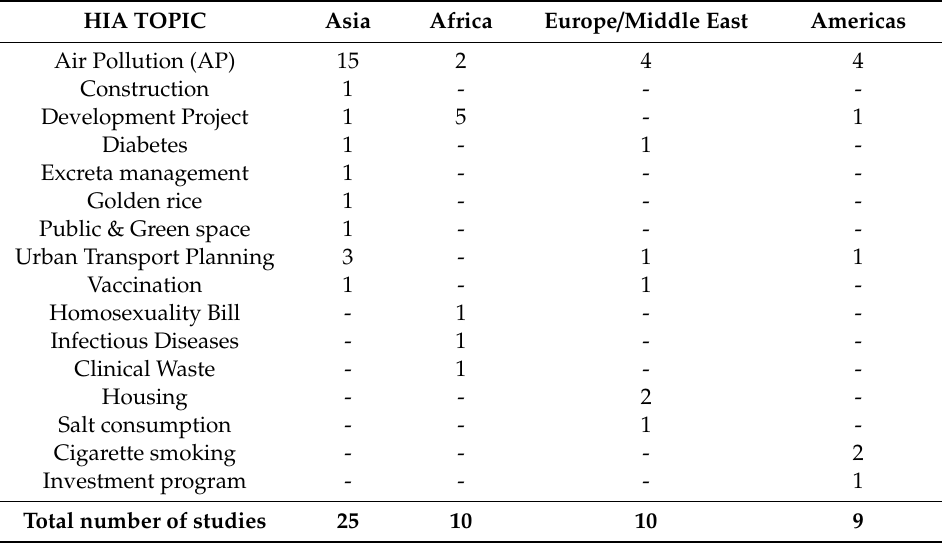
Table 3. Number of studies by region and by topic.